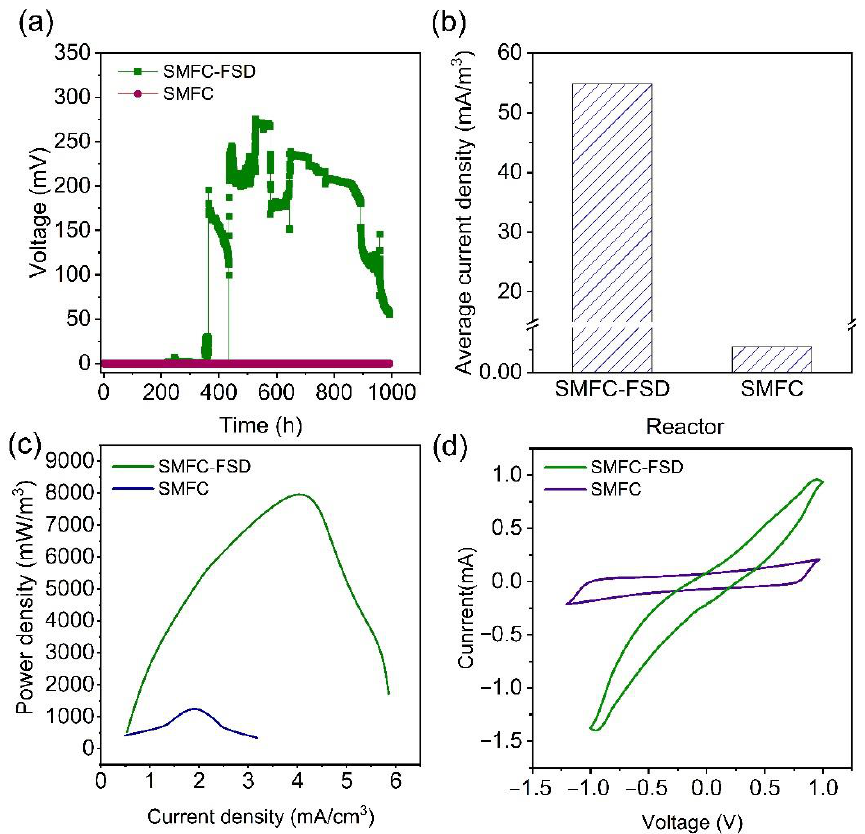
Figure 3. Voltage curve ( a ); average current density ( b ); power density ( c ); and cyclic voltammetry curve ( d ) of the SMFC - FSD and SMFC reactors.